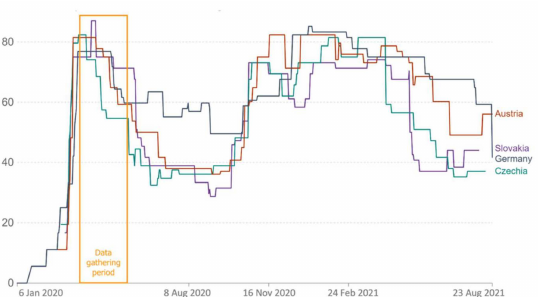
Figure 2. The strictness of the mitigation efforts in all four countries within the data gathering period. The composite measure is based on nine response indicators including school closures, workplace closures, and travel bans, rescaled to a value from 0 to 100 (100 = strictest). If policies vary at the subnational level, the index is shown as the response level of the strictest sub-region. Source: Hale, T.; Angrist, N.; Goldszmidt, R.; et al. A global panel database of pandemic policies (Oxford COVID-19 Government Response Tracker). Nat. Hum. Behav. 2021 , 5 , 529–538.